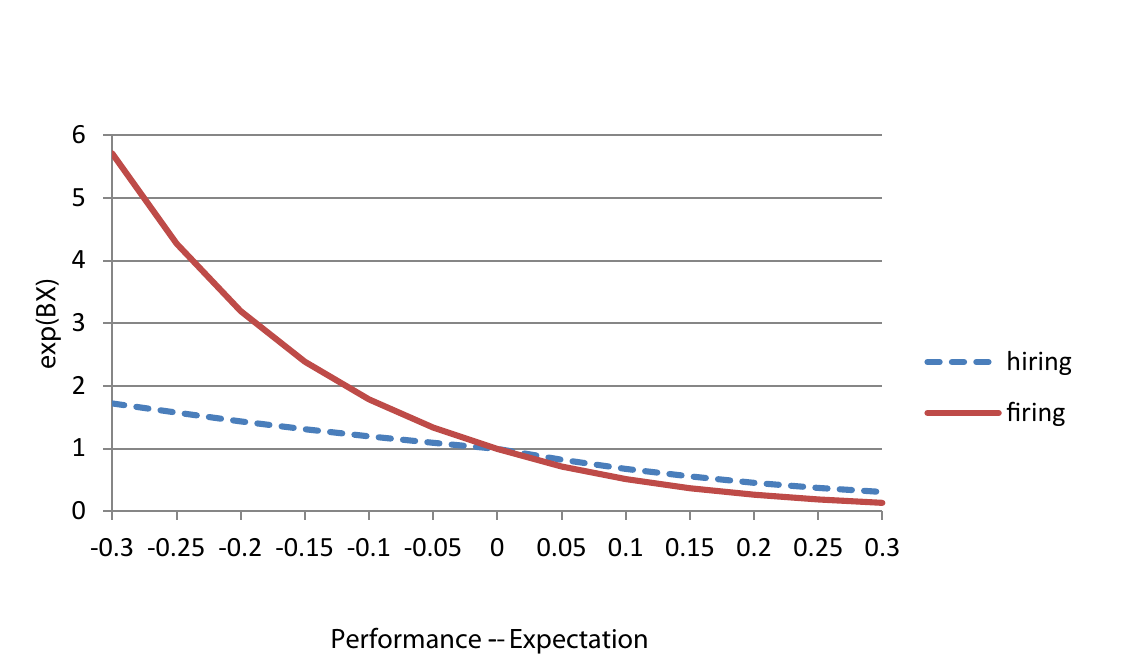
Figure 3: Estimated hazard multipliers for performance relative to historical expectation.